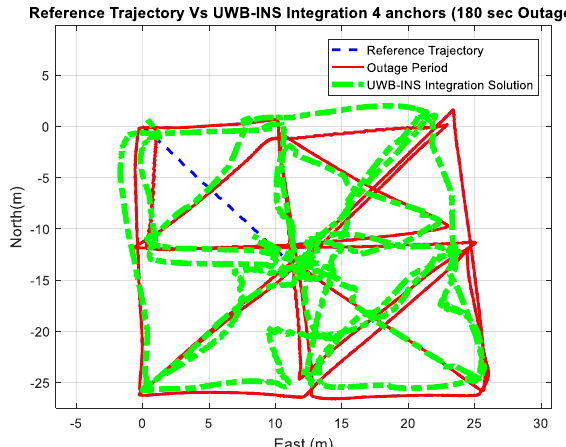
Figure 17. The solution from the UWB system alone with lower infrastructure (configuration e )